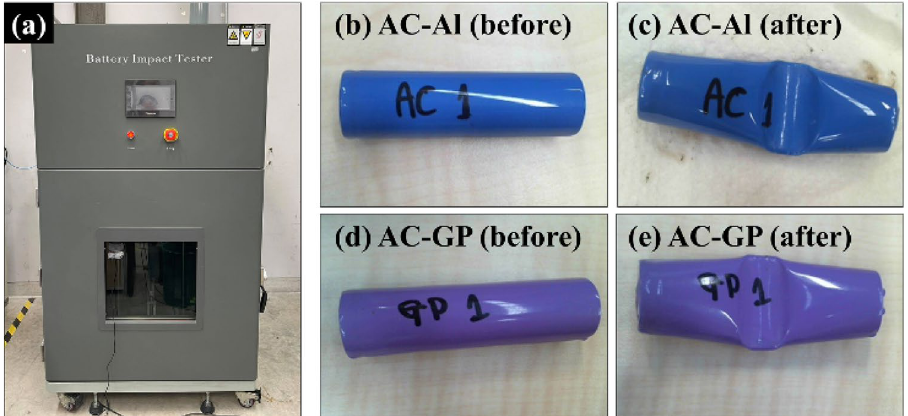
Figure 7. ( a ) Battery impact tester, ( b , c ) AC-Al cylindrical cell, and ( d – e ) AC-GP cylindrical cells before and after the impact test according to the UN38.3